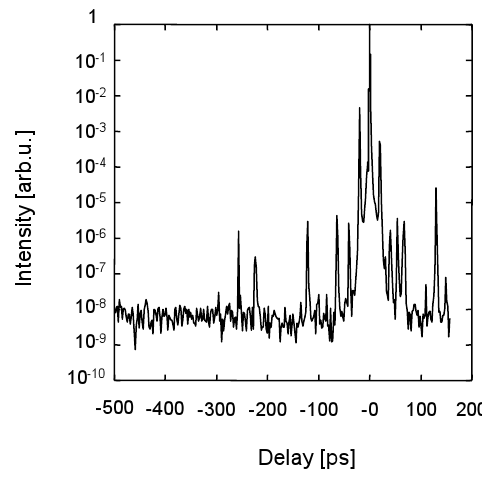
Figure 24. Contrast of the recompressed